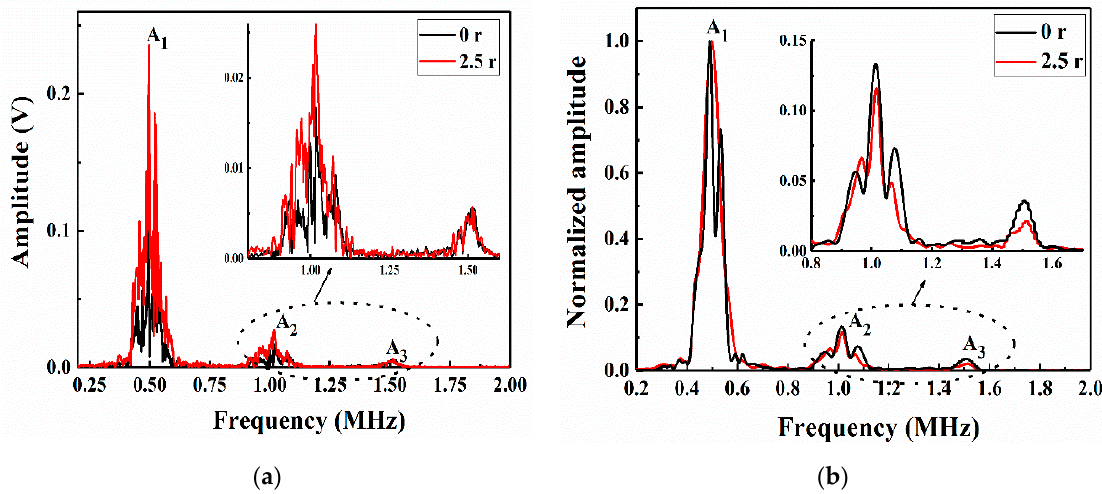
Figure 12. Frequency-domain responses in the numerical model of the unrepaired and repaired CFRP laminates: ( a ) actual amplitude and ( b ) normalized envelope amplitude.